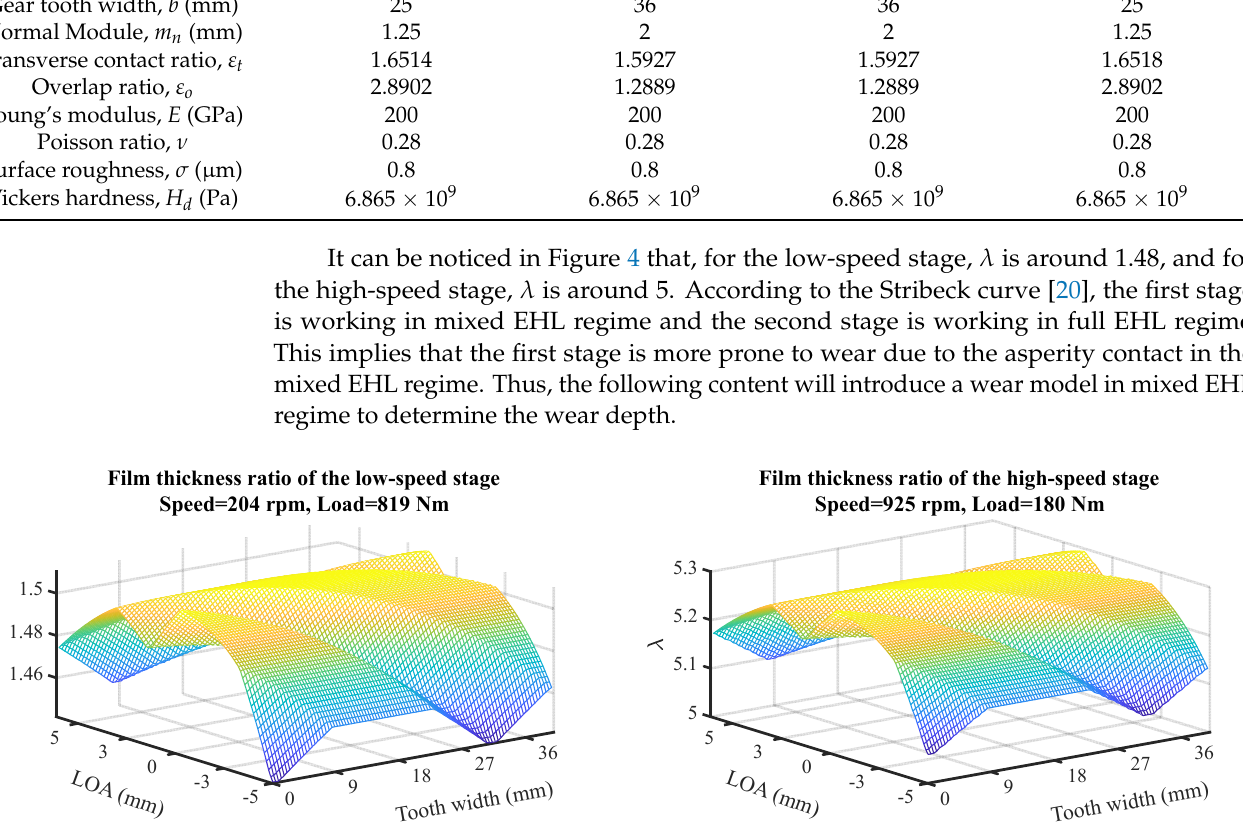
Figure 4. Film thickness ratio of the two stages in GB2. (LOA: line of action).